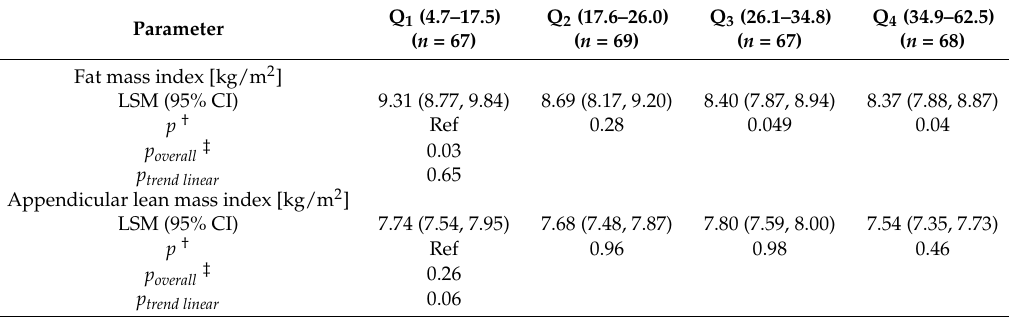
Table 2. Body composition parameters by 25-hydroxyvitamin D [ng/mL] quartiles (Q 1 –Q 4 ) for total